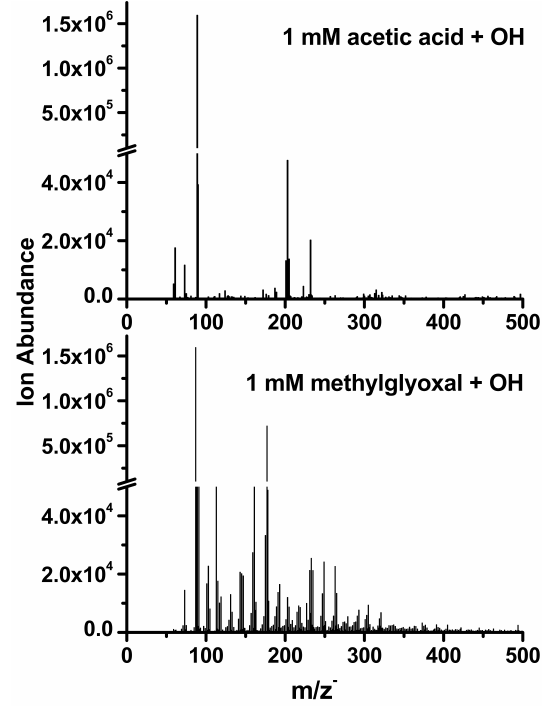
Fig. 4. ESI mass spectra of 1mM acetic acid+OH radical experi- ment (120min reaction time) and 1mM methylglyoxal+OH radical experiment (120min reaction time).